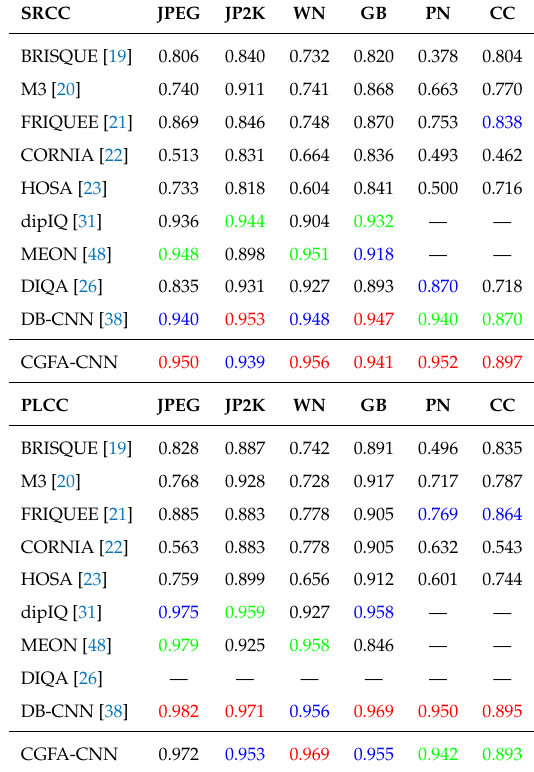
Table 4. Average SRCC and PLCC results of individual distortion types across ten sessions on CSIQ database. The top three SRCC and PLCC results are highlighted in red, green, and blue, respectively.